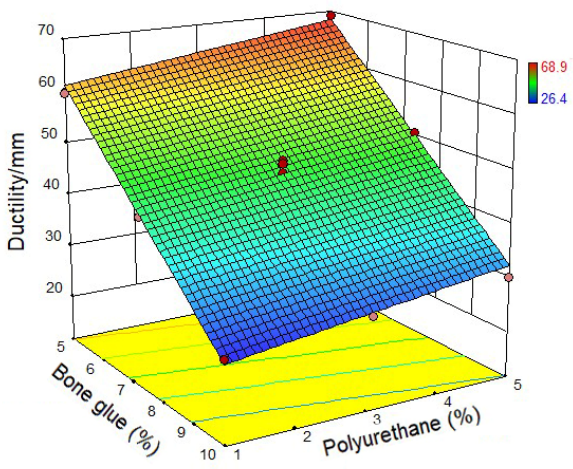
Figure 5. Soften point of CMA.